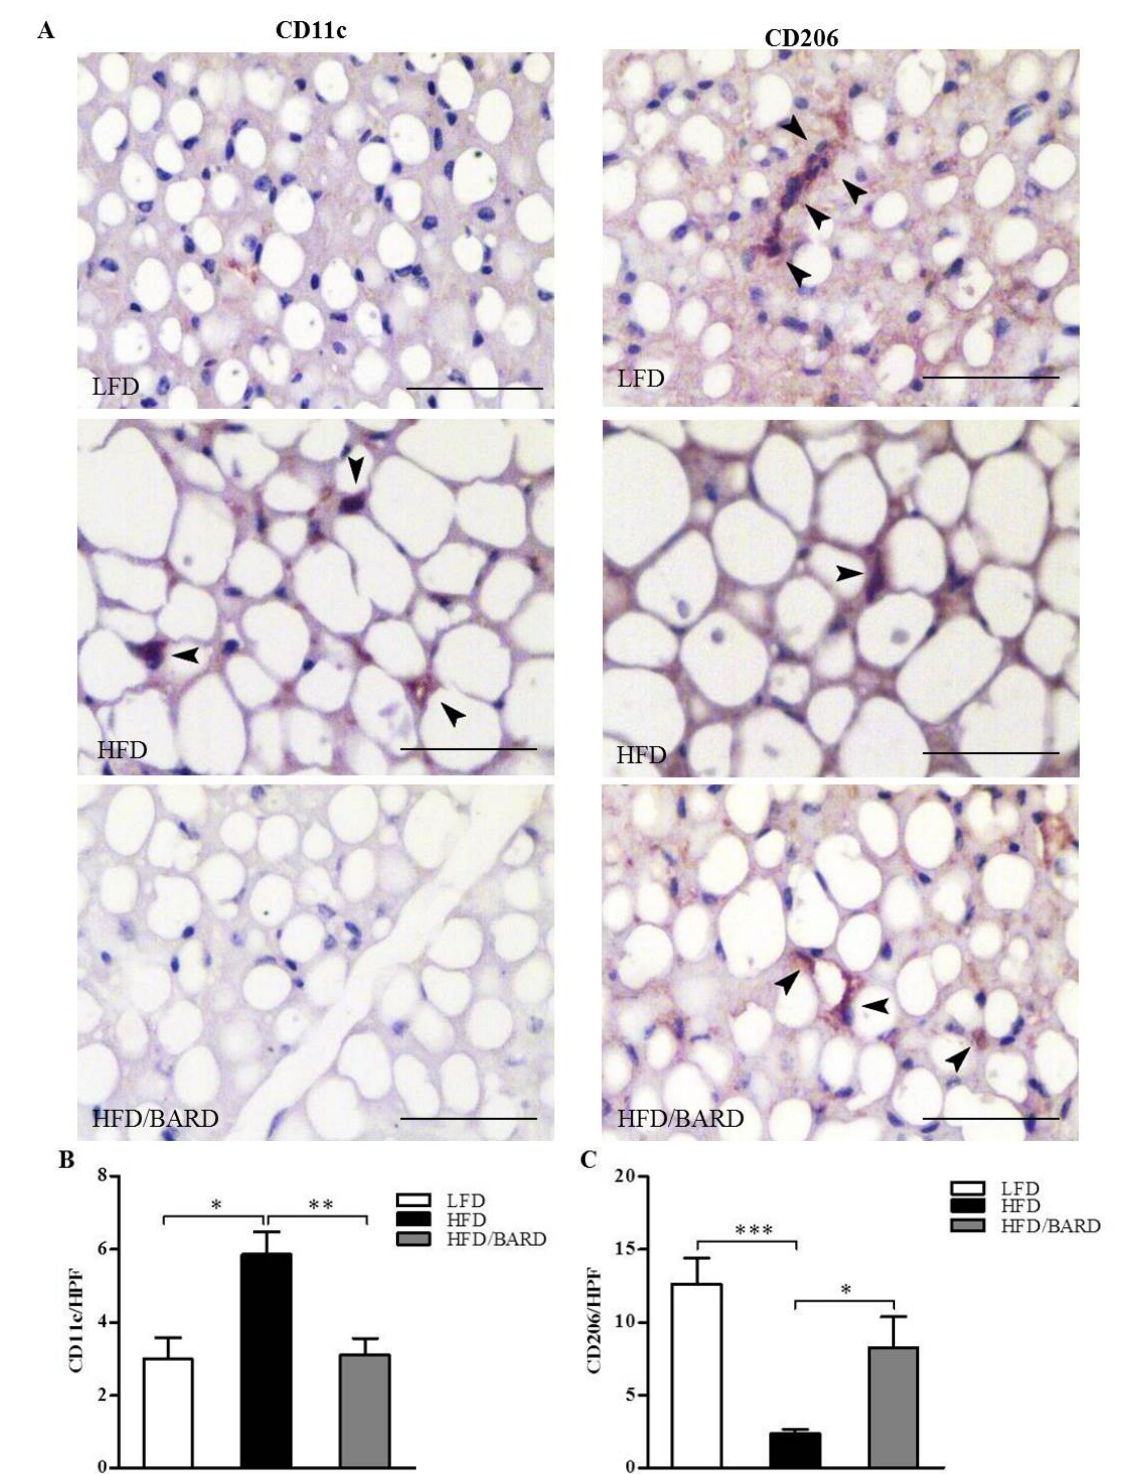
Figure 3. Effects of bardoxolone methyl (BARD) on the expression of CD11c and CD206 macrophages in brown adipose tissue of mice fed: low-fat diet (LFD), high-fat diet (HFD), and high-fat diet supplemented with BARD (HFD/BARD). ( A ) CD11c and CD206 stained sections (×40). Bar = 50 µm; ( B ) Number of CD11c-positive stained cells per high-power field (HPF); ( C ) Number of CD206-positive stained cells per HPF. All data are mean ± SEM. * p < 0.0.05, ** p < 0.01, *** p <